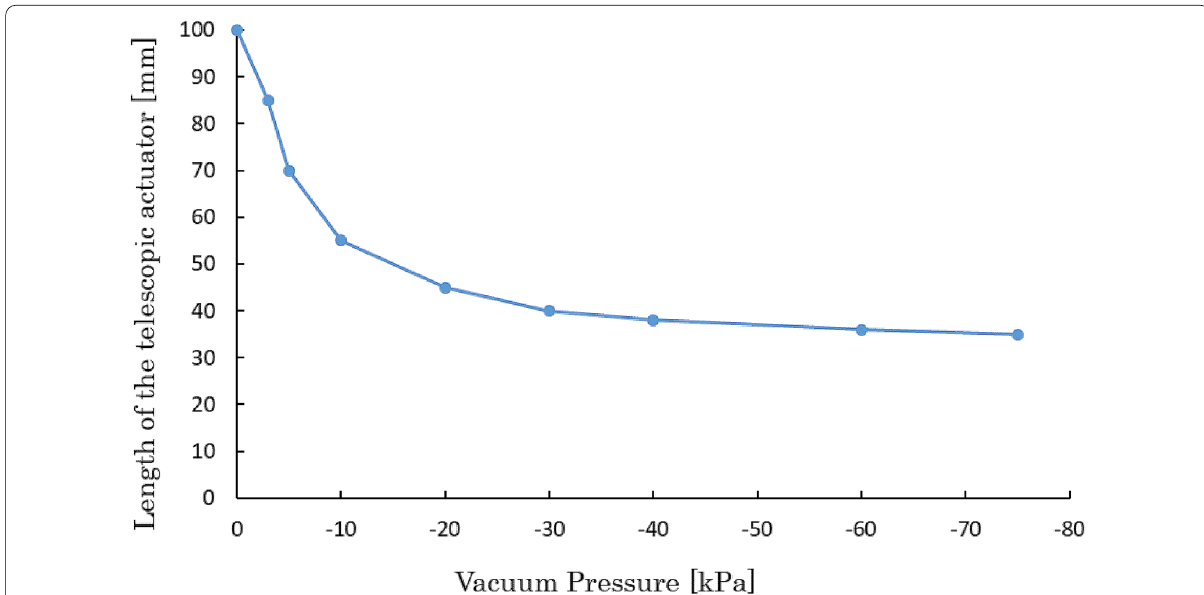
Fig. 4 Relationship between the length of the telescopic actuator and internal air pressure. The telescopic actuator contracted significantly from atmospheric pressure to approximately 10 kPa and then contracted gradually. The length of the telescopic actuator does not include that of the − membrane and the wooden pieces attached to both ends of the